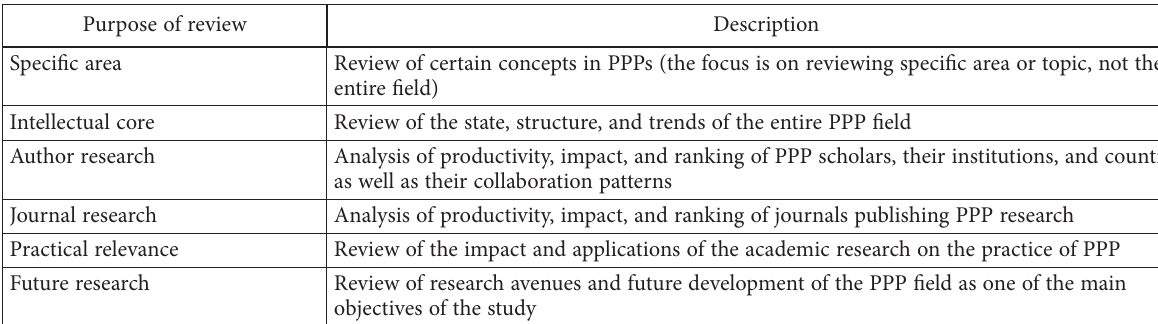
Table 2. Purpose of the literature review studies in PPP